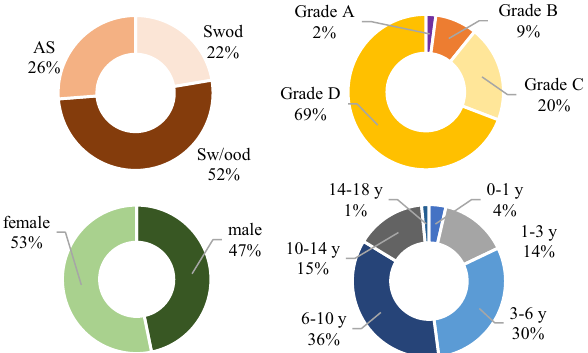
Figure 1. Clinical symptoms and diagnoses, ALN grades, sexes, and ages of the 206,775